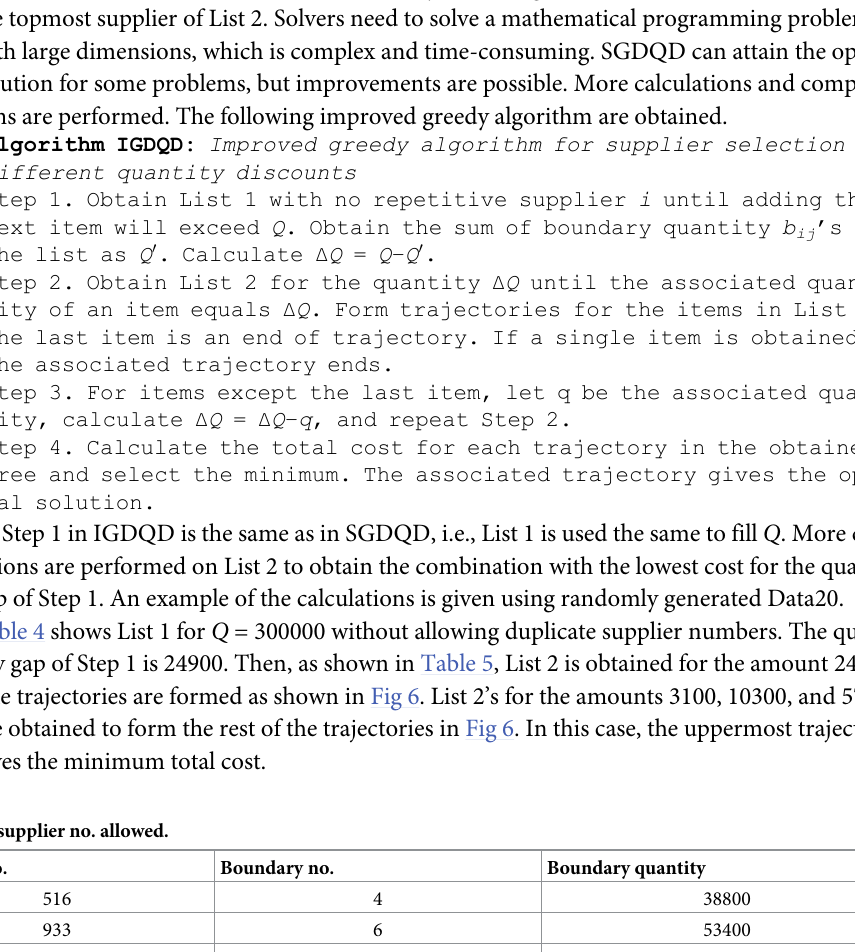
Algorithm IGDQD: Improved greedy algorithm for supplier selection with